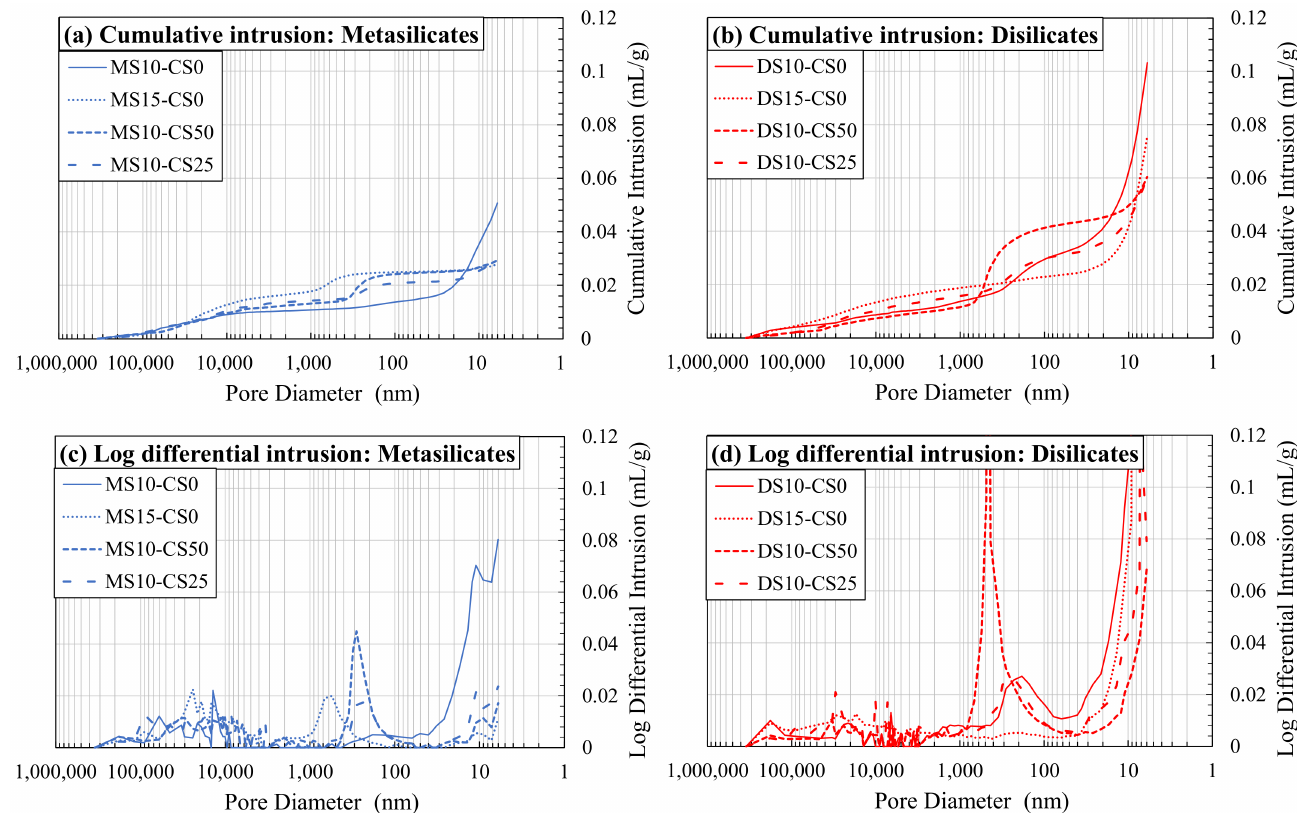
Figure 9. Mercury intrusion porosimetry (MIP) as cumulative intrusion ( a , b ) and log differential intrusion ( c , d ) in function of pore diameter for metasilicates ( a , c ) and disilicates ( b , d ) (See Table 2 for mix